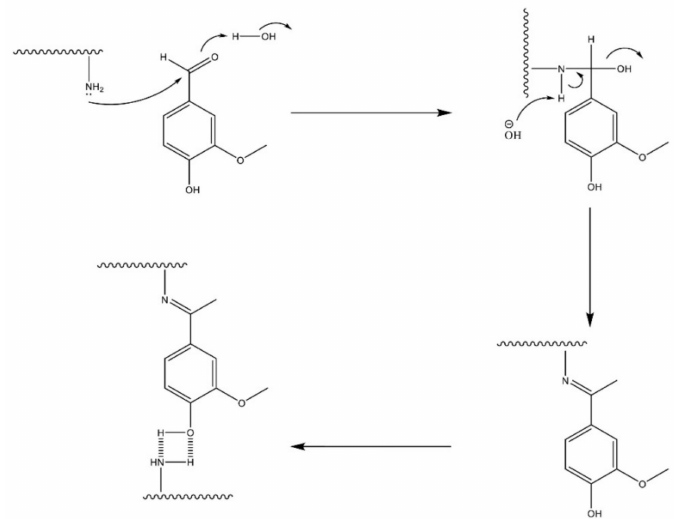
Figure 13. Chemical cross-linking reaction of chitosan using vanillin [193]. Reproduced with permis- sion from Elsevier